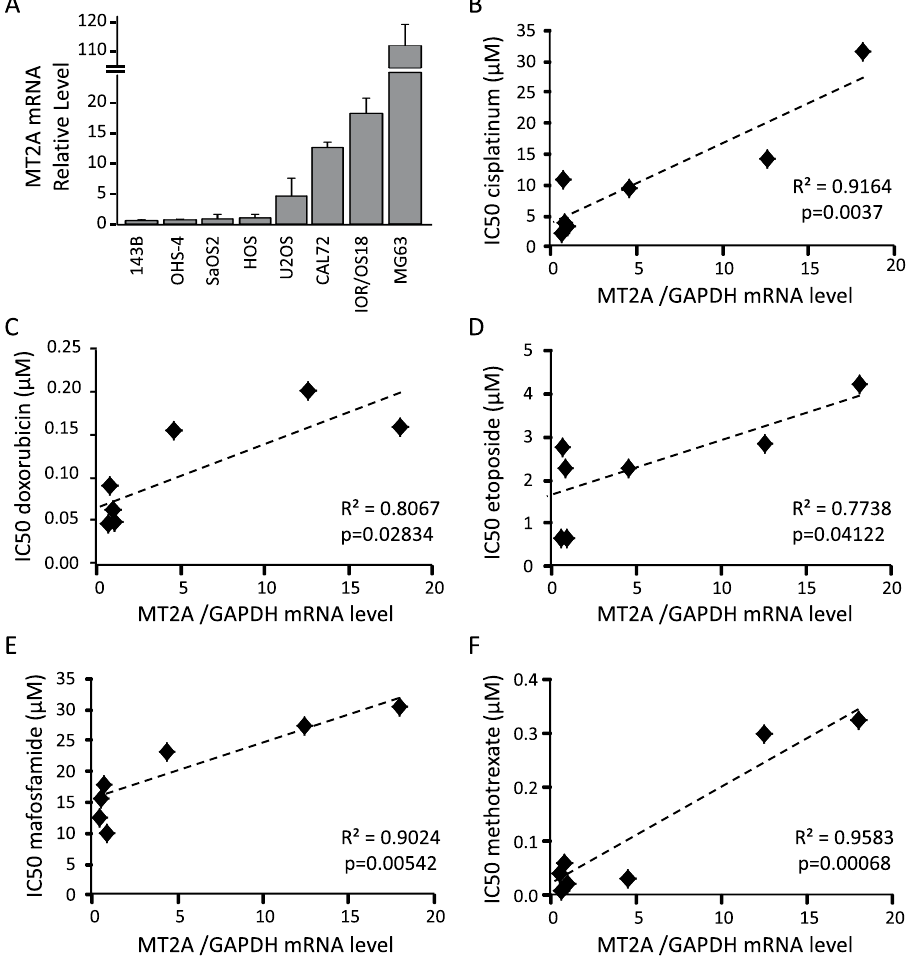
Figure 1. Correlation between MT2A mRNA level and IC50 values for chemotherapeutic drugs. ( A ) Expression pattern of MT2A in a panel of osteosarcoma cell lines, as assessed by RT-qPCR. GAPDH was used as internal reference gene. The relative mRNA level was calculated using the 2 −ΔΔ CT method and expressed as mean ± standard deviation (n = 3–5). ( B – F ) Spearman correlation between the MT2A mRNA level and half maximal inhibitory concentration (IC50) values determined for cisplatinum ( B ), doxorubicin ( C ), etoposide ( D ), mafosfamide ( E ) and methotrexate ( F ). The black line shows the regression line. The determination coefficient R² and the significance of the F test (P-value) are also